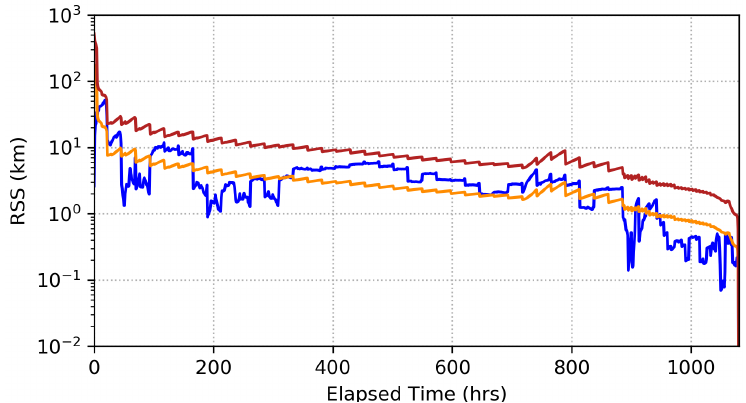
Figure 13. Position error (blue) and RTPC uncertainty (1- σ (orange) and 3- σ (red)) for fused filter in Large Radiometric Bias setup.